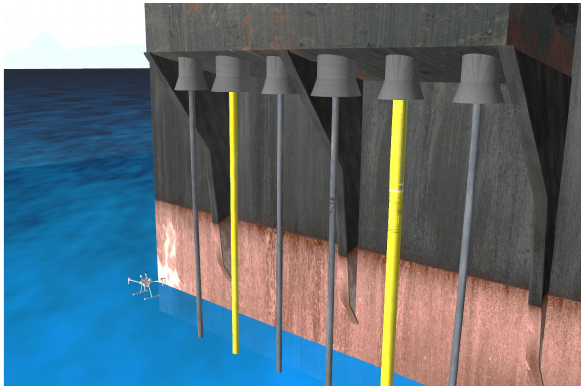
Figure 3. Simulated scenario with six risers and high-quality textures from actual in-field photos.